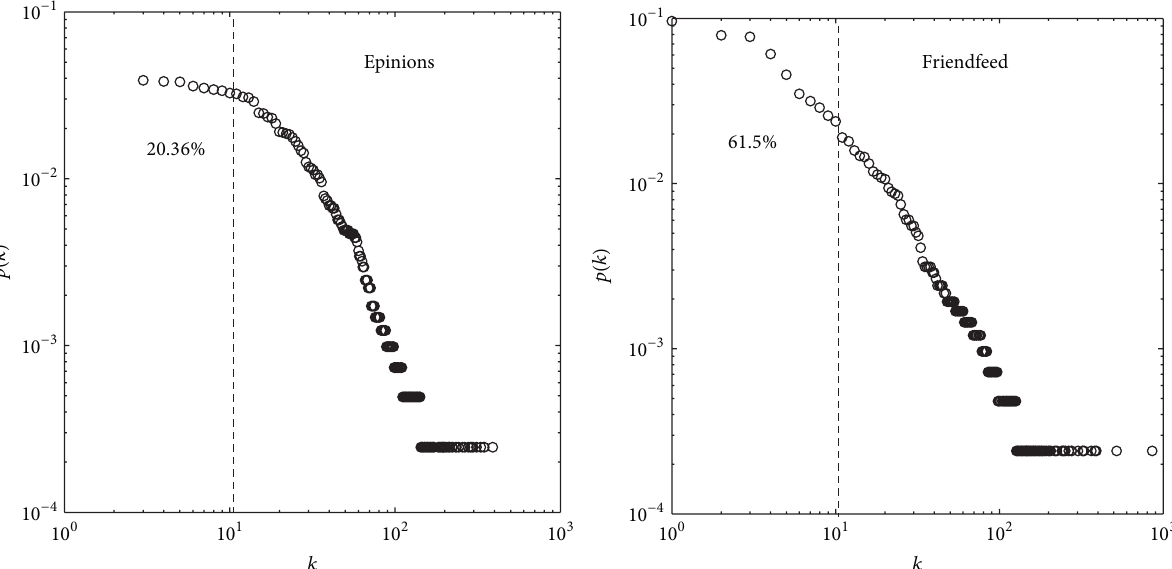
Figure 4: The user degree distribution of training set on Epinions and Friendfeed data sets.